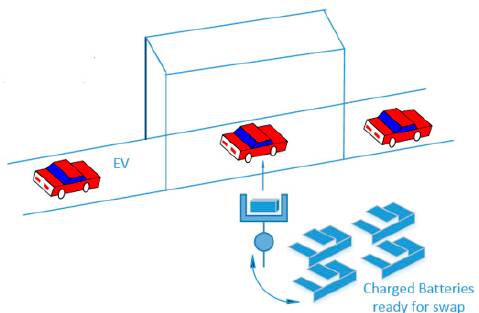
Figure 1. Conceptual design of a battery swapping station (BSS).